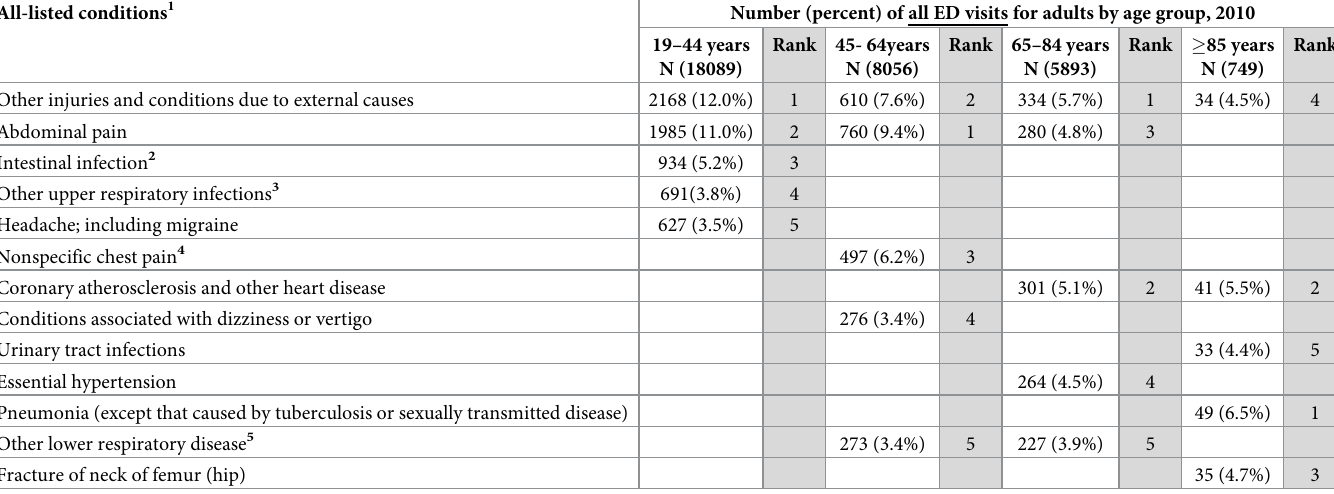
Table 4. Most common reasons for all ED visits for adults by age